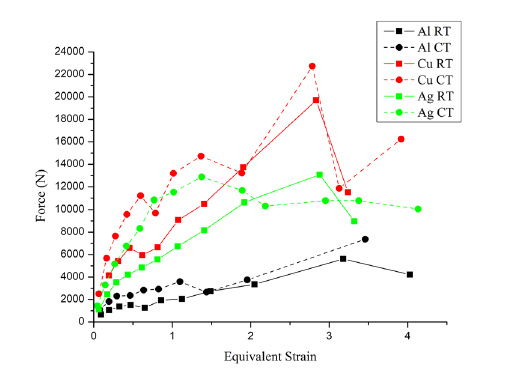
Figure 3. Force variation over rolling steps.